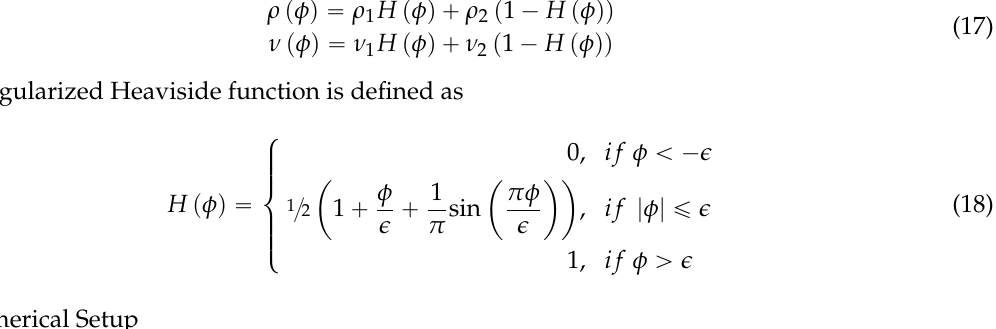
Figure 6. Measured water level fluctuations for the whole period and for the section selected for numerical modeling with the modeled values included (5.8 m from bank (ADV #3)). The presented section was chosen for numerical modeling because both the wave heights and the near ‐ bed velocities were the one of the highest then, which is believed to be crucial considering near ‐ bed habitats. It is noted that from the ecological aspect, vessel ‐ induced drawdown may also have negative effects as the drawdown temporarily result in habitat area loss [11], however, this study does not aim to investigate this effect. The boundary conditions on the left end of the domain were defined based on pressure measurements taken 3.8 m closer to the bank (ADV #3), thus wave transformation might be expected.